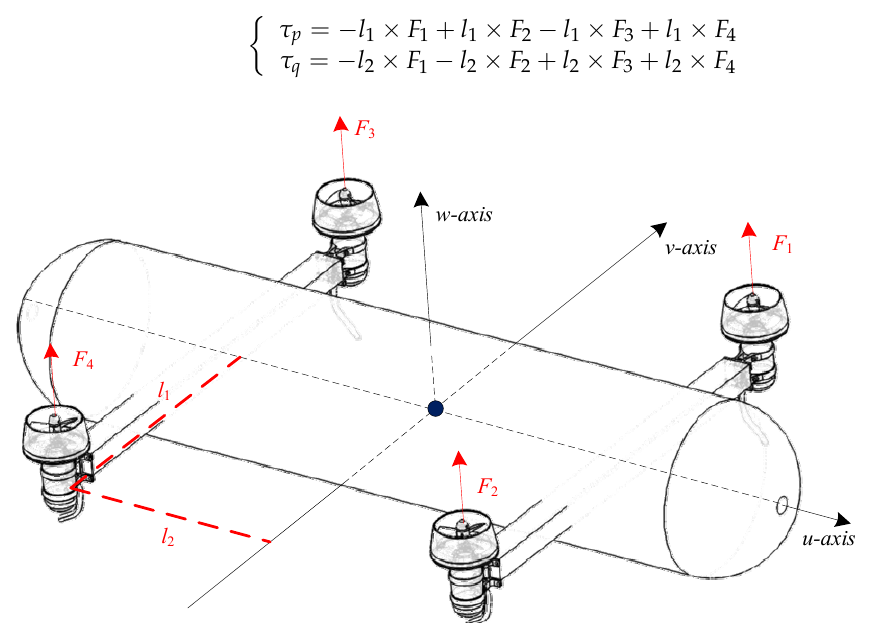
Figure 5. Schematic diagram of thrust distribution by four heave thrusters.